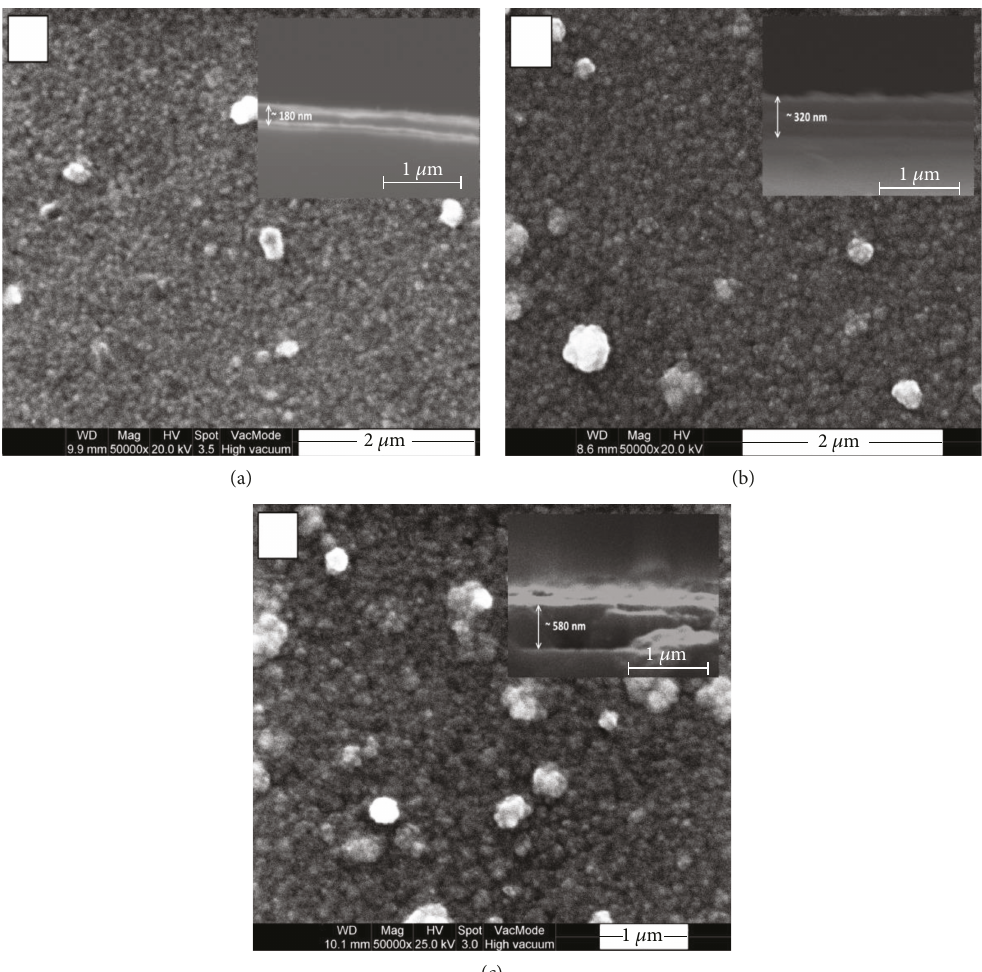
Figure 5: SEM micrographs and cross-sectional view of CdS thin fi lms: (a) 1 run, (b) 3 runs, and (c) 5 runs with the deposition time of 5 min.